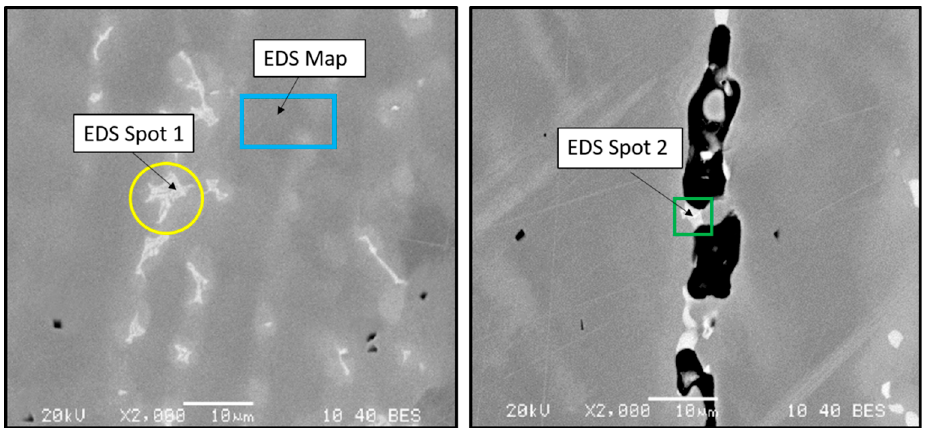
Figure 13. BSE images depicting the matrix, white intermetallic and constitute near the crack in the microstructure.